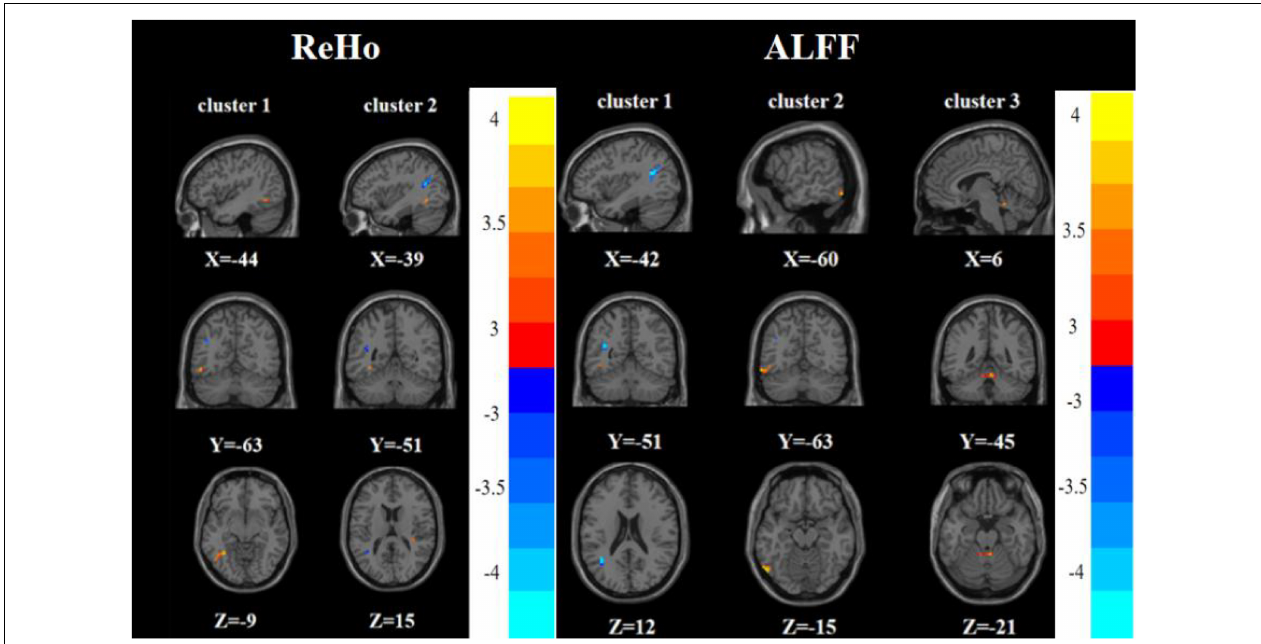
FIGURE 5 | Brain regions with abnormal ReHo (left) and ALFF (right) between the FDE group and the HC group based on a post hoc t -test. The color bars indicate the T -value.